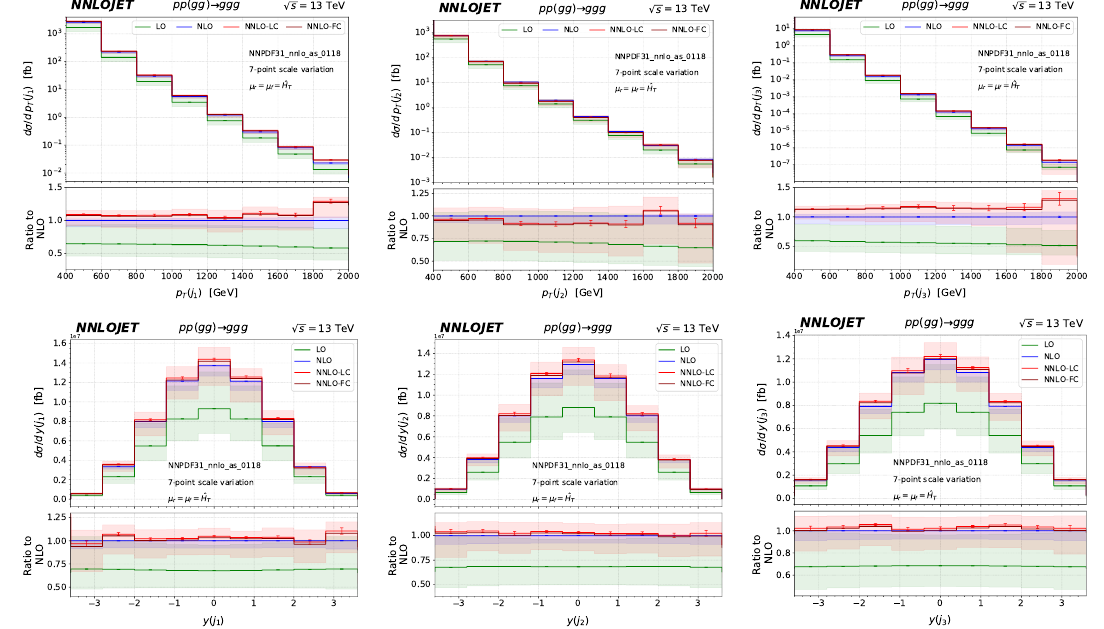
Figure 7 . Differential distributions in individual jet transverse momenta (upper row) and rapidities (lower row) for gluons-only three-jet production up to NNLO. Definition of NNLO-LC and NNLO-FC as in figure 6.